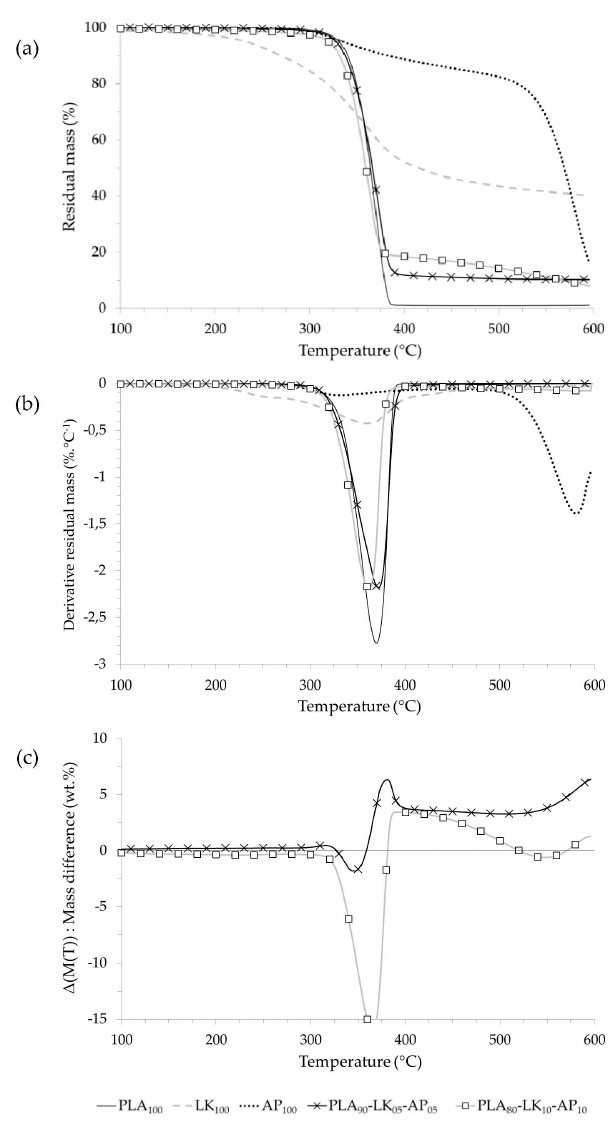
Figure 5. ( a ) TG; ( b ) DTG; and ( c ) mass difference curves of PLA-LK-AP composites.